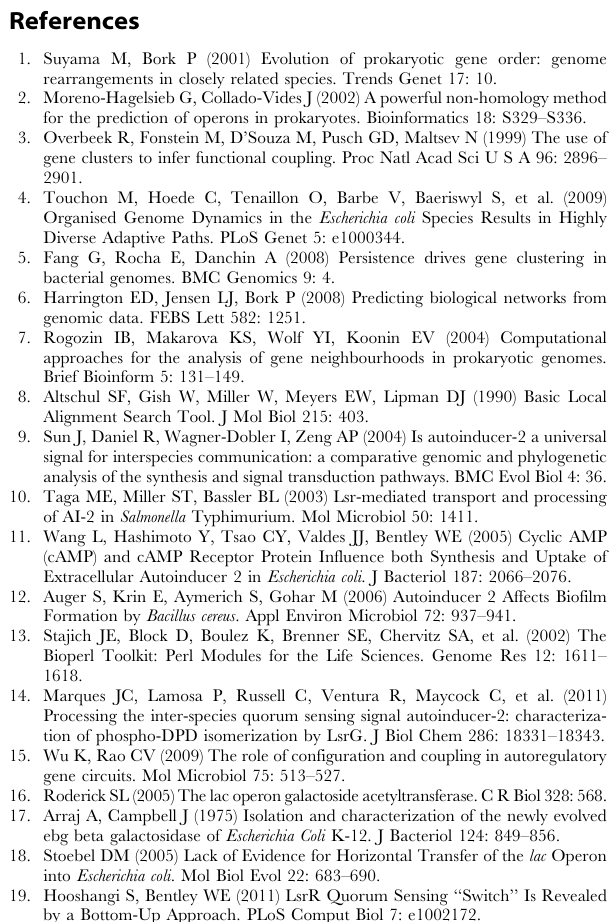
searches used stringent criteria (higher penalties for deviation from the query pattern and adherence to supplied annotation). ‘‘Join’’ indicates a difficulty in handling uncommon annotation where the first gene annotated in a record spans the end and the beginning of the record. Arrow direction indicates the direction of transcription along the genome. Color is a stand-in for character type, and the degree of shading indicates degree of element homology, with the darkest shade representing 100% element homology.